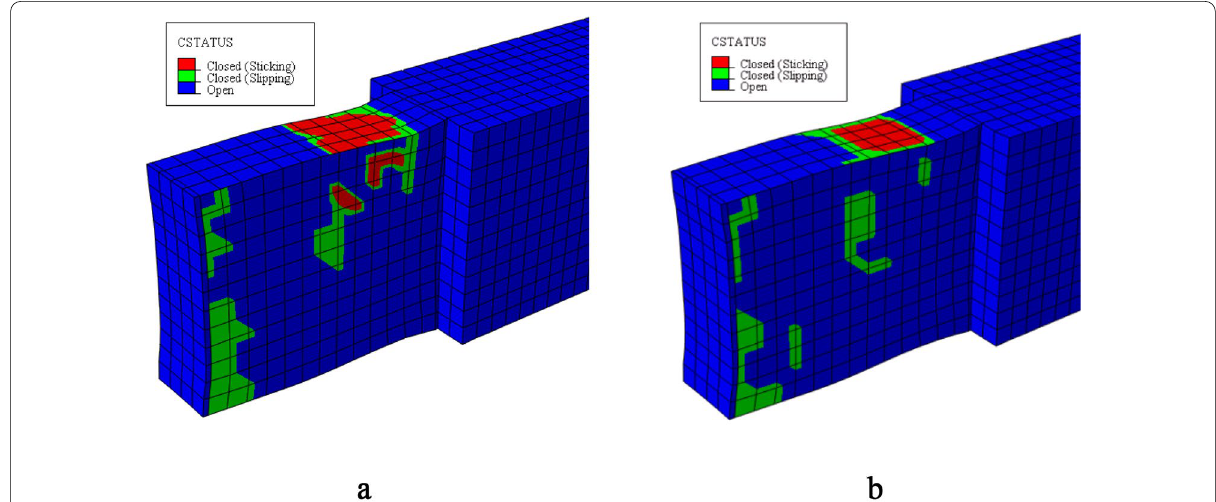
Fig. 31 Contact state of contact surface in the reverse loading stage: a VC-FEM; b